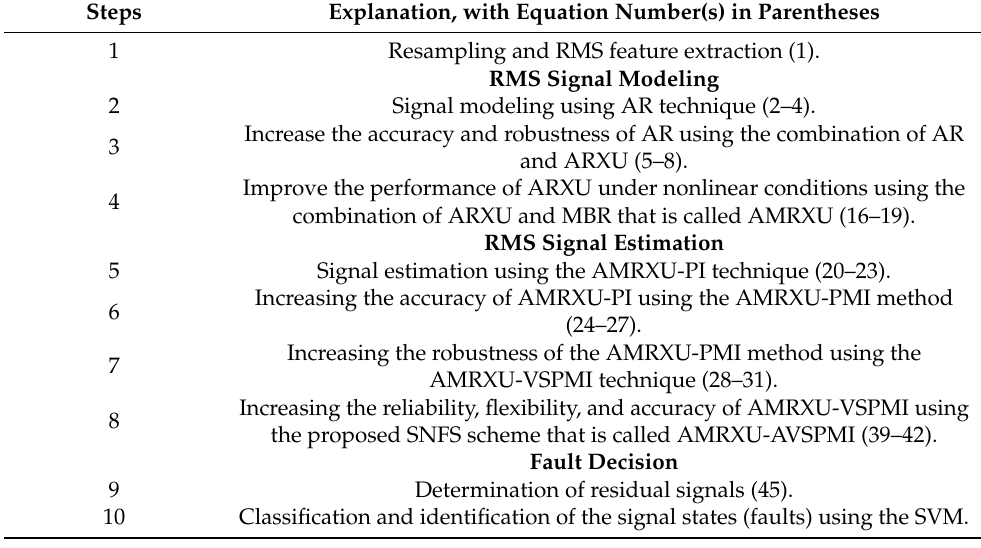
Table 3. Summary of the proposed scheme’s